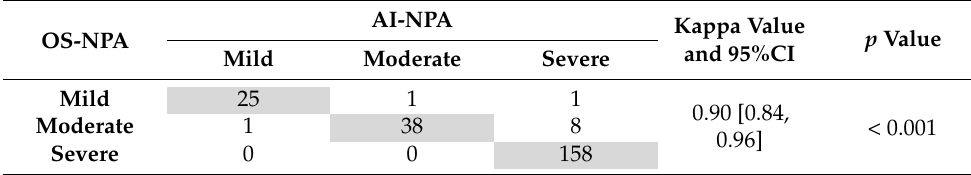
Table 3. Consistency analysis of NIPS pain grading by OS-NPA and AI-NPA.